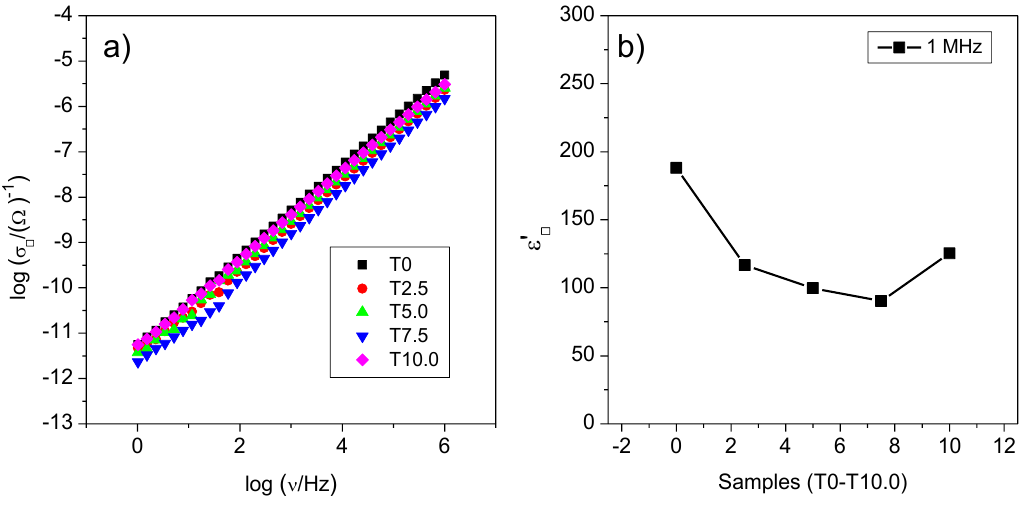
Figure 7. ( a ) Conductivity spectra for all samples, ( b ) and dielectric permittivity as a function of silica addition measured at room temperature.